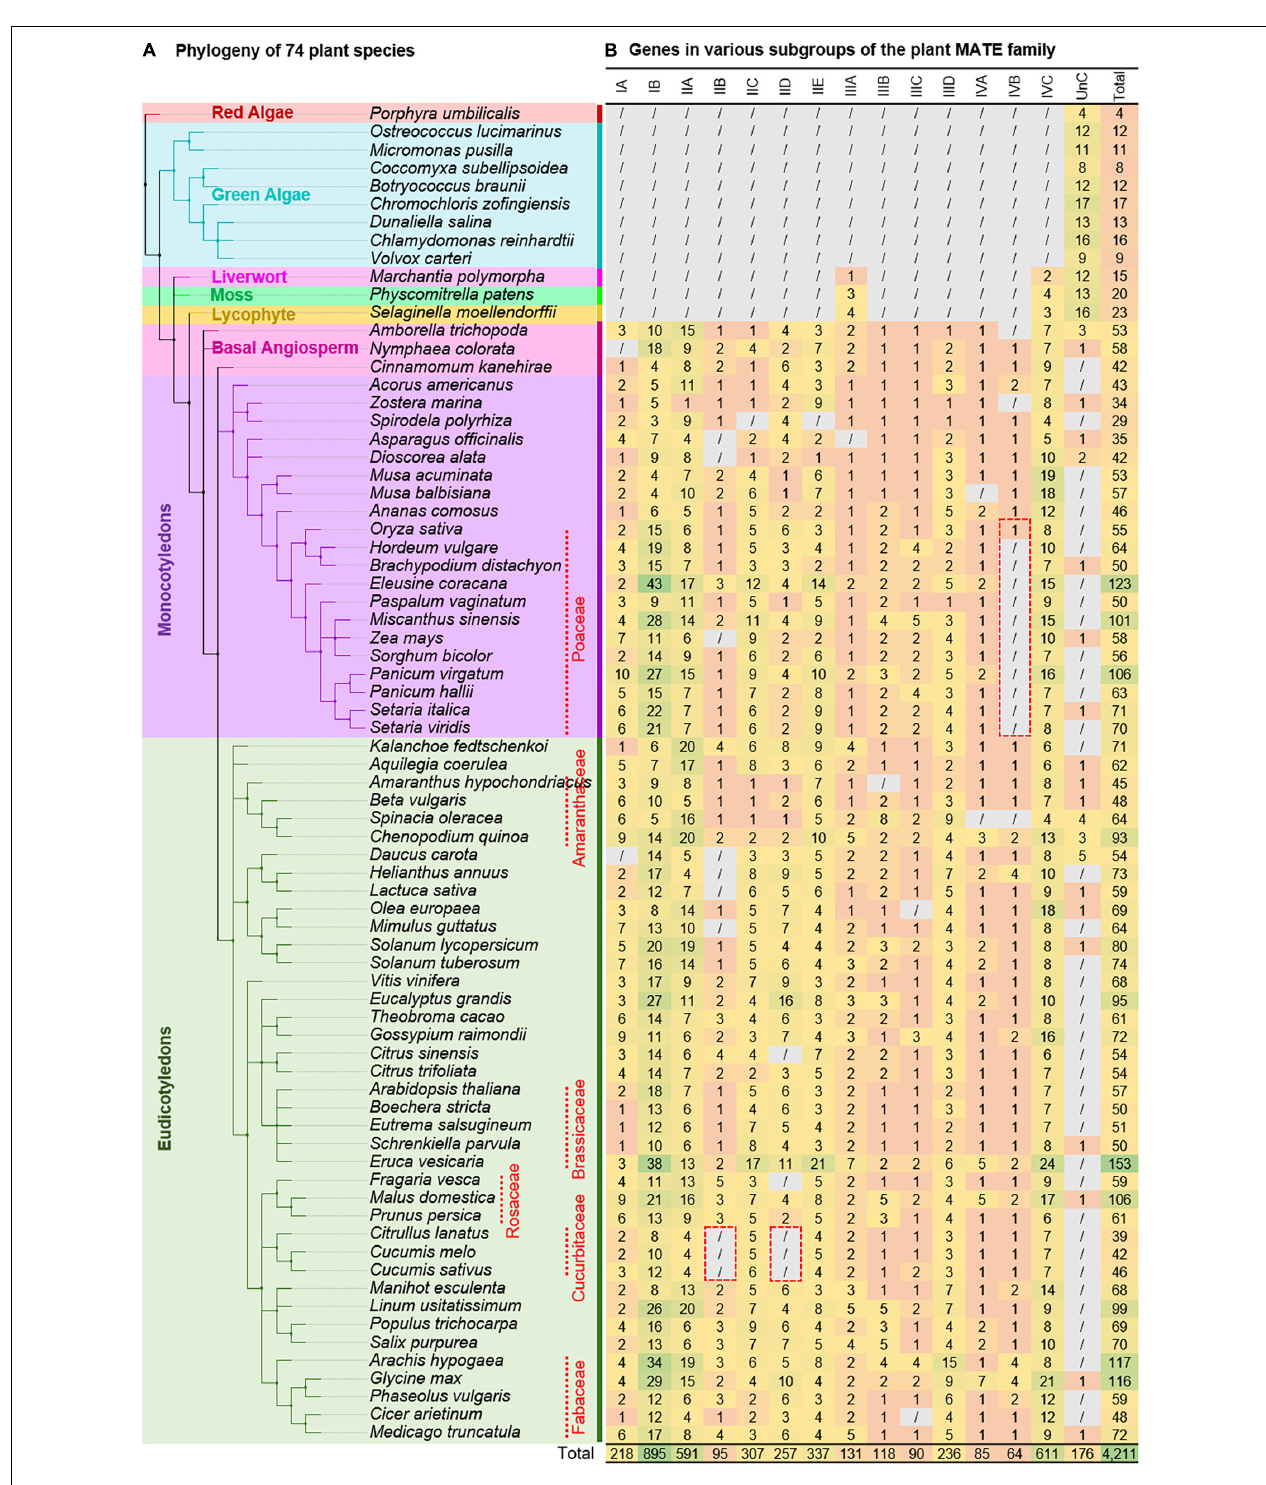
FIGURE 1 | Distribution of multidrug and toxic compound extrusion (MATE) transporters across the plant kingdom. The phylogeny of 74 plant species (A) was inferred using the NCBI Taxonomy Browser (https://www.ncbi.nlm.nih.gov/Taxonomy/Browser/wwwtax.cgi). The number of MATEs in different subgroups of each plant genome is shown next to the species names (B) . Numbers are colored based on abundance. “/” denotes not detected. Subgroups are assigned based on ≥ 60% protein sequence identity threshold using a set of bioinformatic tools (see section “Systematic Identification, Classification, and Phylogeny of Plant Multidrug and Toxic Compound Extrusion Transporters” for